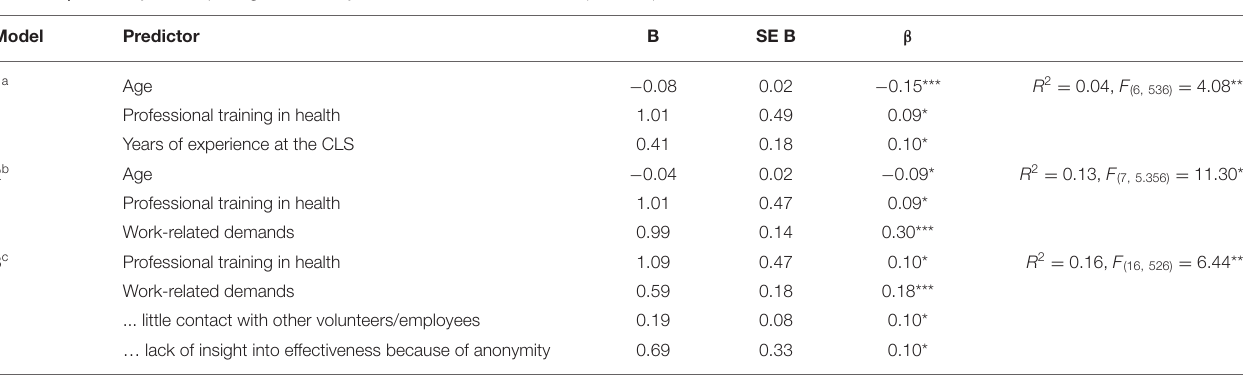
TABLE 5 | Summary of multiple regression analysis of determinants of distress ( N = 543).